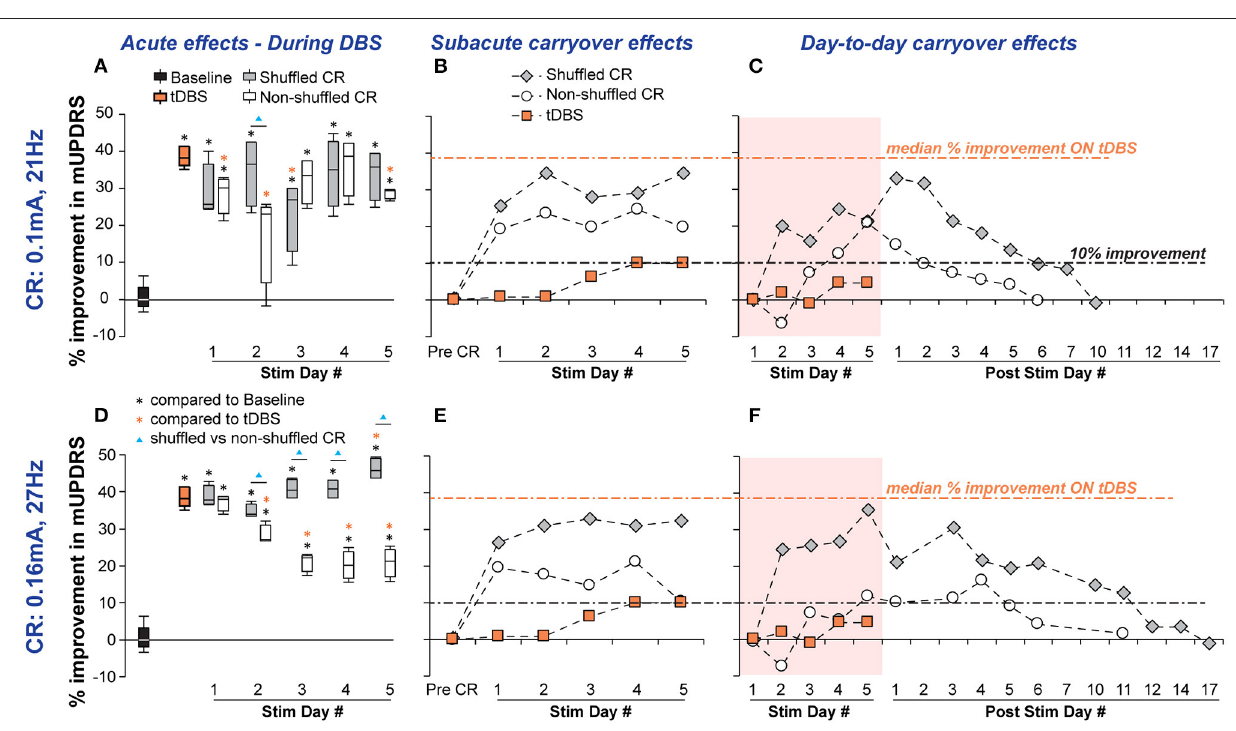
FIGURE 3 | Acute and carryover improvements in mUPDRS acquired by shuffled and non-shuffled CR DBS in NHP B in two conditions: (i) CR DBS with a default stimulation intensity of 0.1mA and burst frequency at 21Hz (Top row) and (ii) CR DBS with the more effective stimulation intensity of 0.16mA and burst frequency at 27Hz (Bottom row). (A,D) Acute motor benefits across stimulation days measured by the percentage of improvement in mUPDRS compared with the baseline between shuffled and non-shuffled CR DBS were compared in each condition. Statistical comparisons were performed using the same method for NHP J (*, N p < 0.05). (B,E) Subacute carryover effects of CR DBS indicated by the percentage of improvement in the post-DBS mUPDRS. (C,F) Day-to-day carryover effects of CR DBS indicated by the percentage of improvement in the daily morning mUPDRS on stimulation and post-stimulation